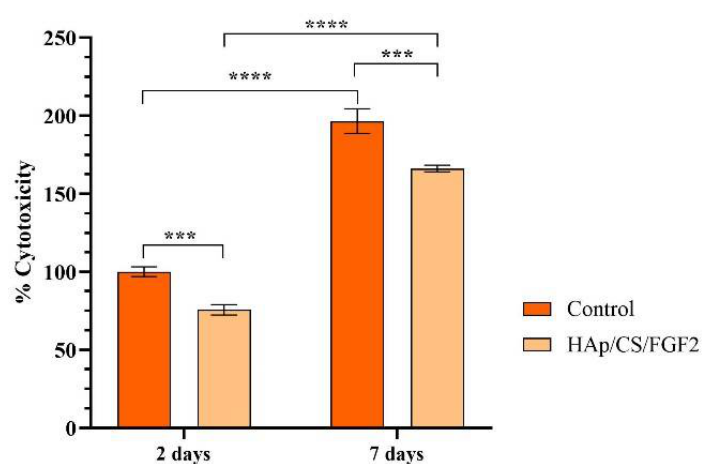
Figure 6. Graphical representation of LDH leakage levels from damaged MC3T3-E1 cells after 2 days and 7 days of contact with control and HAp/CS/FGF2 samples as a measure of materials cytotoxicity (*** p < 0.001; **** p < 0.0001).